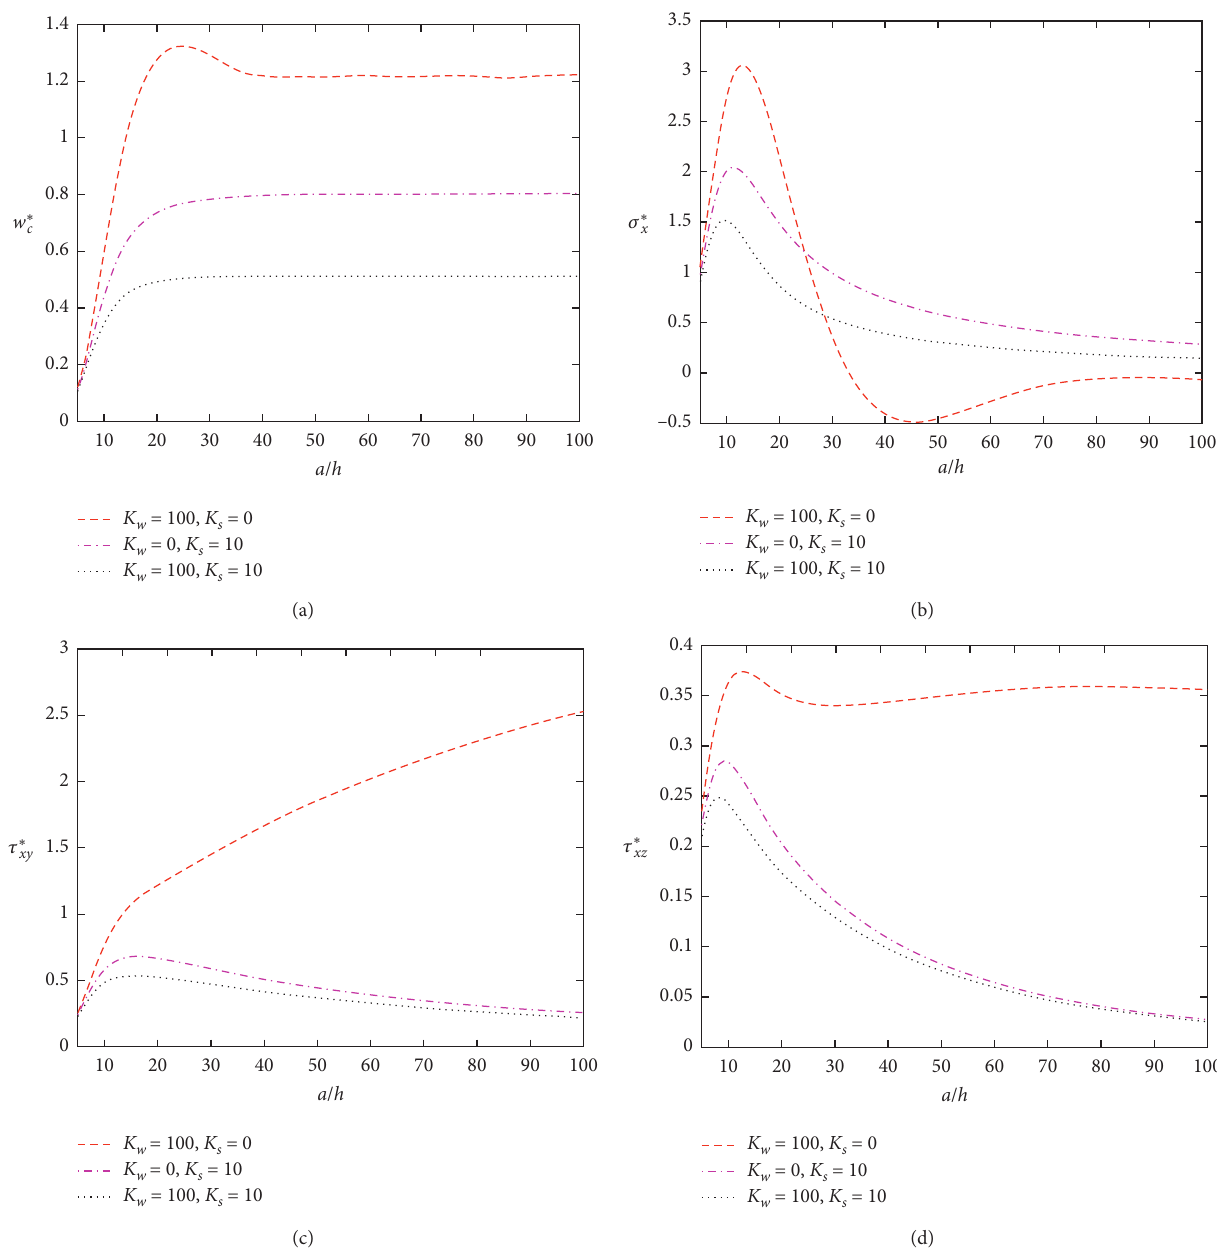
Figure 5: The variation of the deflection and stresses as the functions of the side-to-thickness ratio.